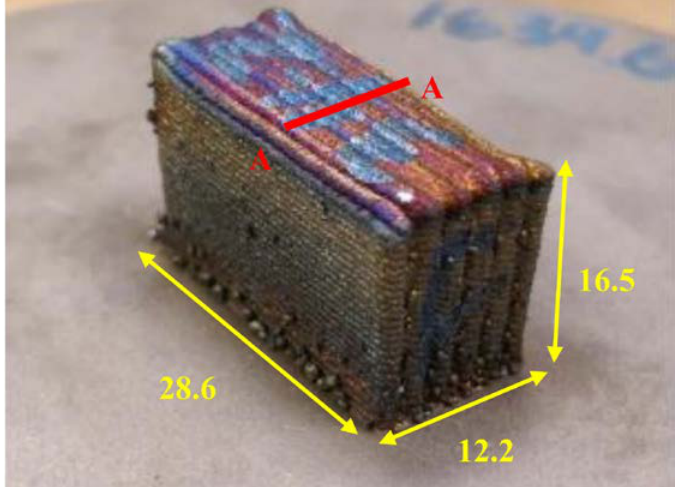
Figure 4. Multilayer builds (measurements in mm).